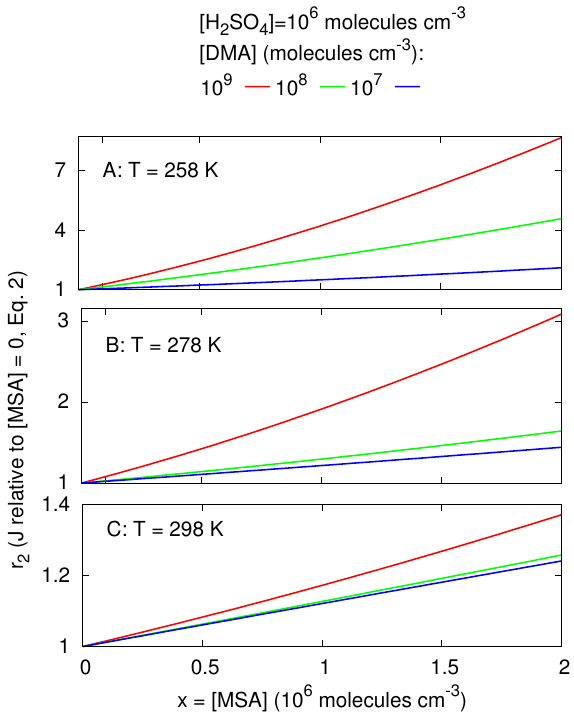
Figure 2. MSA–H 2 SO 4 –DMA-based particle formation rates at varying MSA concentrations relative to [ MSA ] = 0 (Eq. 2).